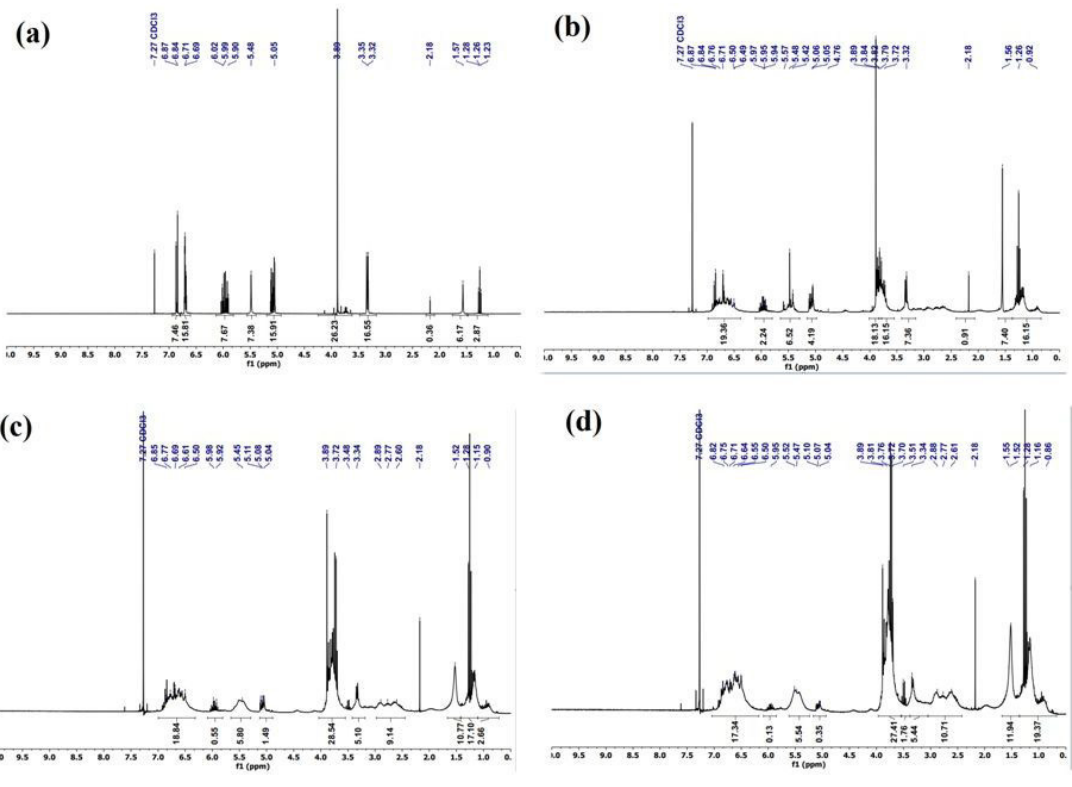
Figure 3. 1 H-NMR spectra of (a) eugenol, (b) P10, (c) P20, and (d) P30.